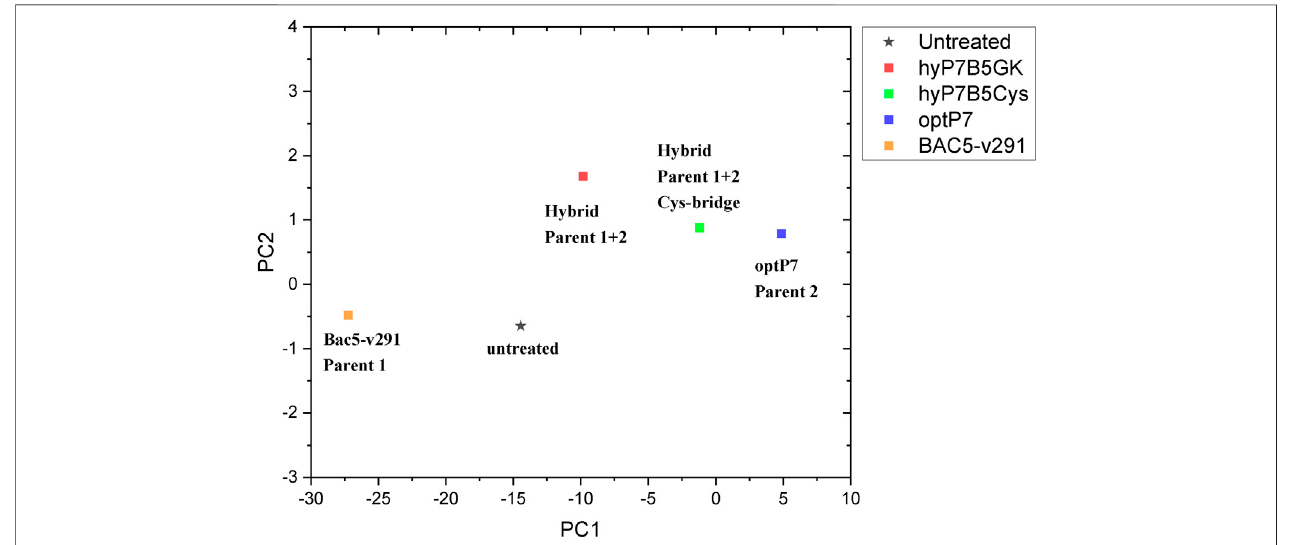
FIGURE 4 | Principal component analysis (PCA) graph, obtained from SAXS curves of E. coli , untreated and treated with four different peptides.